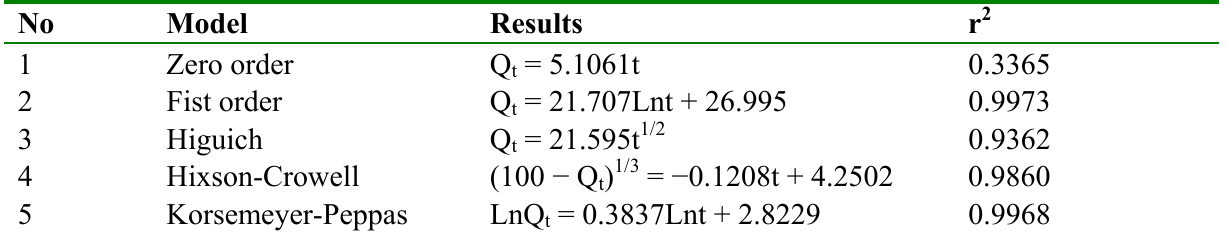
Table 3. Regression result of SA release from stomach retention gel beads.